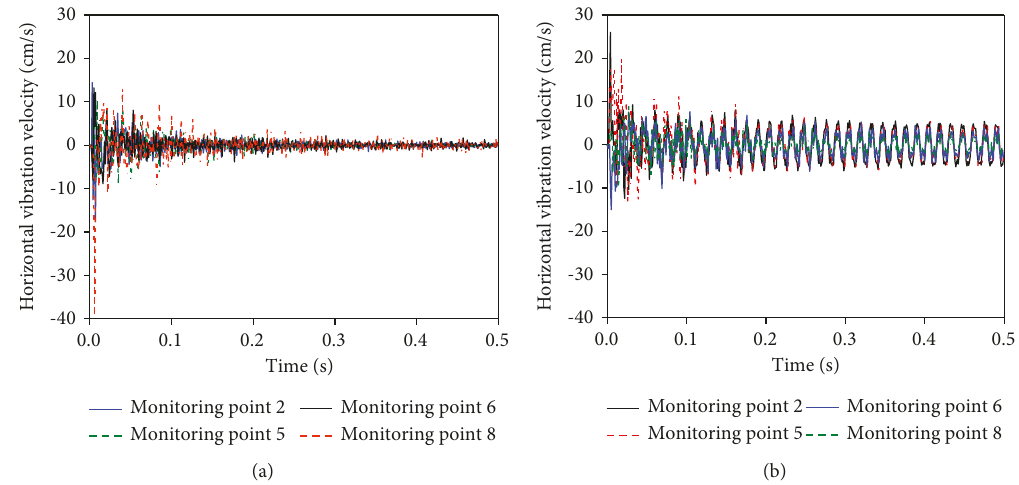
Figure 9: Vibration velocity under the confining pressure of 1MPa. (a) Horizontal velocity. (b) Vertical velocity.